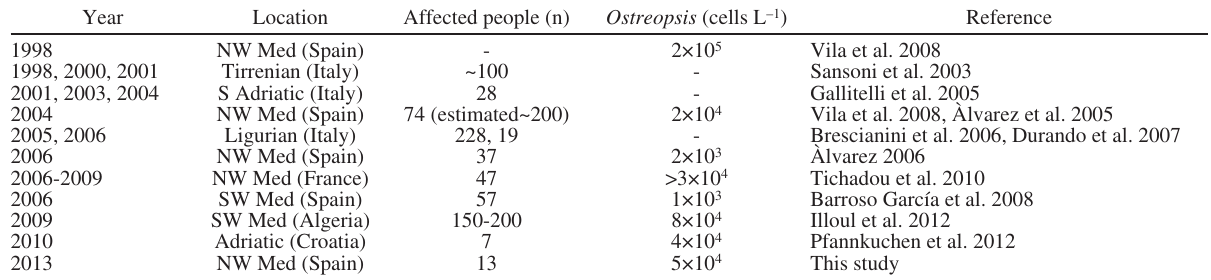
Table 1. – Published studies reporting impacts on human health that have been associated with Ostreopsis cf. ovata blooms in the Mediter- ranean Sea. Cell concentrations refer to the maximum numbers detected in the area, not always coinciding with the health